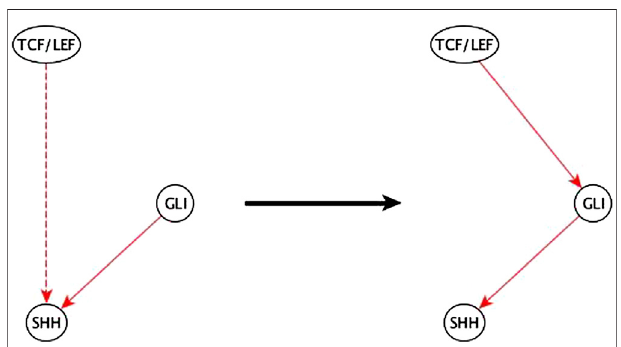
FIGURE 10 | Example of half-known mediator node inference. The inferenceinputinformation revealsthatTCF/LEFisindirectly suf fi cient forSHH and that GLI is directly suf fi cient for SHH. This helps the biologist infer that the indirect suf fi cient regulation of SHH by TCF/LEF could be via GLI and potentially achieved by a TCF/LEF → GLI suf fi cient edge.